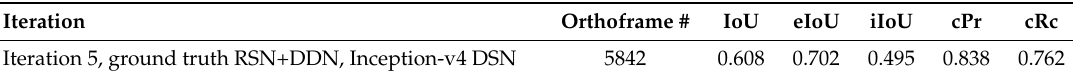
Table 6. Defect segmentation performances computed over the test set, where Road Segmentation Network (RSN) and Defect Detection Network (DDN) networks are replaced with ground